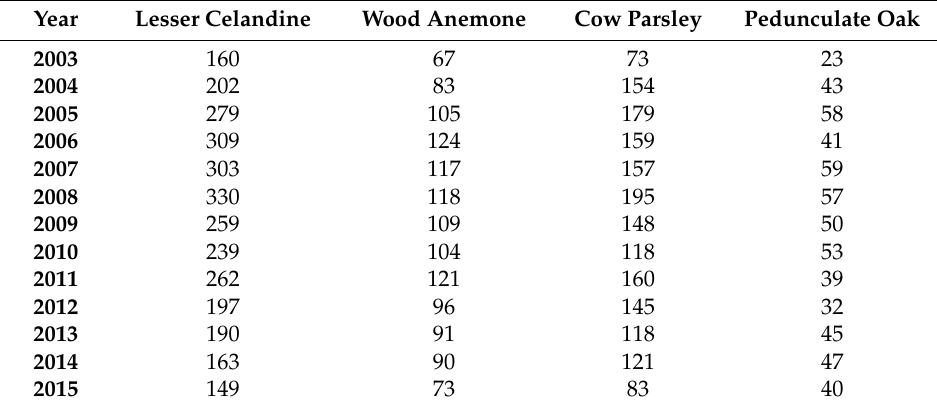
Table 1. The annual number of flowering observations for lesser celandine, wood anemone, and cow parsley and of leafing observations for pedunculate oak. Year Lesser Celandine Wood Anemone Cow Parsley Pedunculate Oak 2003 160 67 73 23 2004 202 83 154 43 279 105 179 58 309 124 159 41 303 117 57